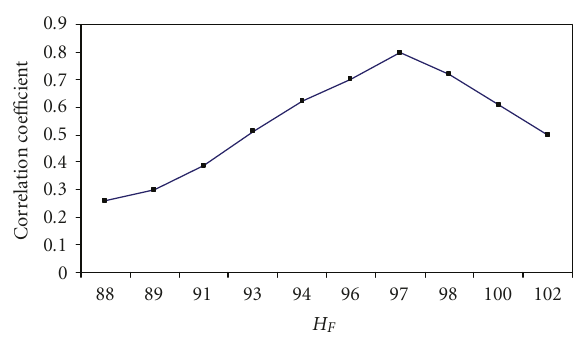
Figure 11: Plot of correlation coe ffi cient of H F same size ∂ k versus H F .